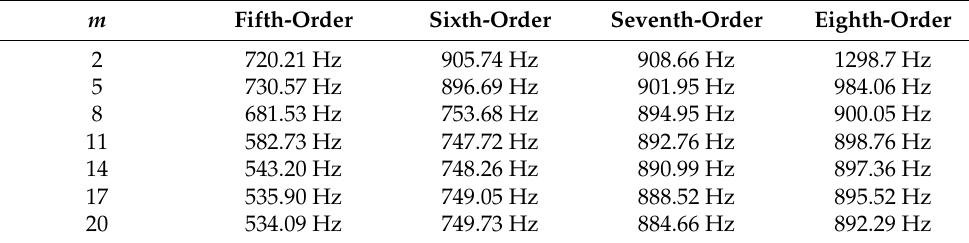
Table 4. Characteristic frequencies of cantilever plates with different power exponents.